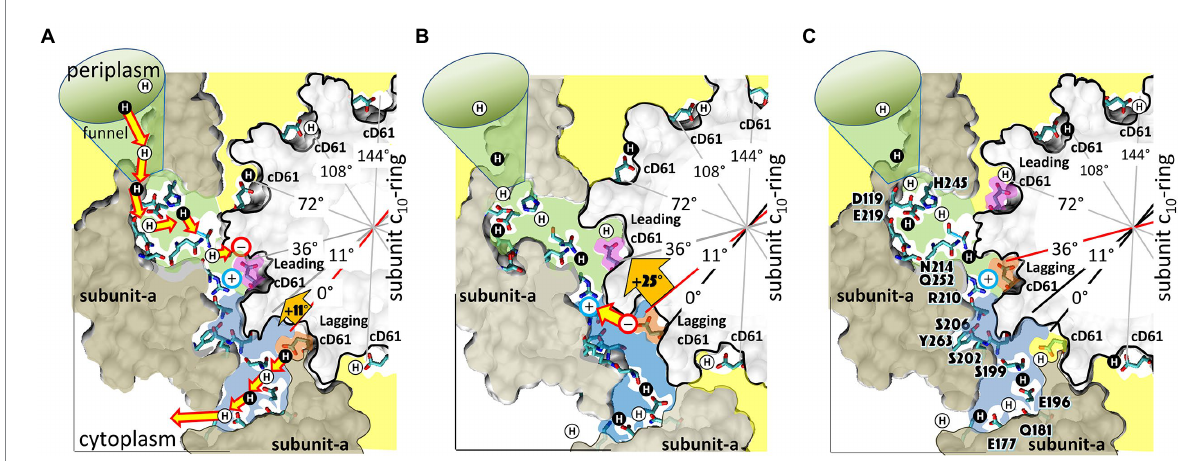
FIGURE 14 Alternating 11 ° and 25 ° sub-steps that power F O c-ring ATP synthase direction rotation. (A) The pH-dependent 11 ° sub-step occurs when H + transfer from aN214/aQ25-bound water to the unprotonated leading cD61-carboxyl (pink), and from the protonated lagging cD61-carboxyl (orange) to aS199/aE196-bound water. Upon displacement from aR210 by protonation, leading cD61 adopts the closed conformation to enable rotation into the lipid bilayer (yellow). Due to coherent H + movement in the Grotthuss column, each H + entering the input channel (green) from the funnel causes a H + to exit the output channel (blue) to the cytoplasm. Rotation occurs when lagging cD61 is deprotonated because the negatively charged carboxyl moves in response to the decrease in hydrophobicity from the lipid bilayer to the water-containing vestibule (blue), and from the electrostatic attraction to aR210. This decreases the distance between the lagging cD61 carboxyl and the aR210-guanidinium from ~11.5 Å to ~7.5 Å. (B) The 25 ° sub-step occurs primarily from the electrostatic interaction between the lagging cD61 carboxy (orange) and the aR210 guanidinium. (C) Electrostatic attraction decreases the distance between orange cD61 and aR210 from ~7.5 Å to ~3.5 Å to complete a 36 ° stepwise c-ring rotation, which positions the orange cD61 to become the leading carboxyl for the next pH-dependent 11 ° sub-step. E. coli F 1 F O cryo-EM structures of rotary sub-states pdb-IDs 5OQS (A,C) , and 5OQR (B) are shown as cross-sections of F O with hydrophobic resides of subunit-a (brown) and the c-ring (gray) along the plane defined by cD61 groups as viewed from the periplasm. Protons are alternately colored black and white to show the progression of proton transfer events. This figure was modified from Yanagisawa and Frasch,